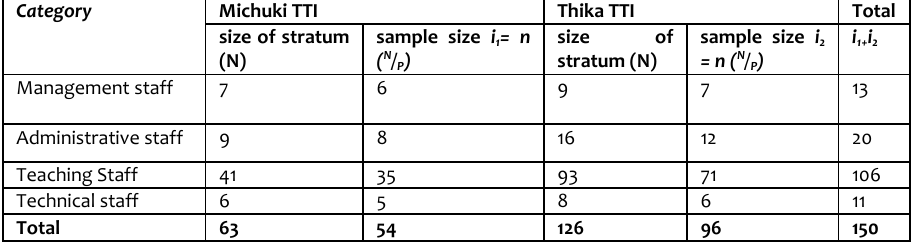
Table 2 : Distribution of population sample Michuki